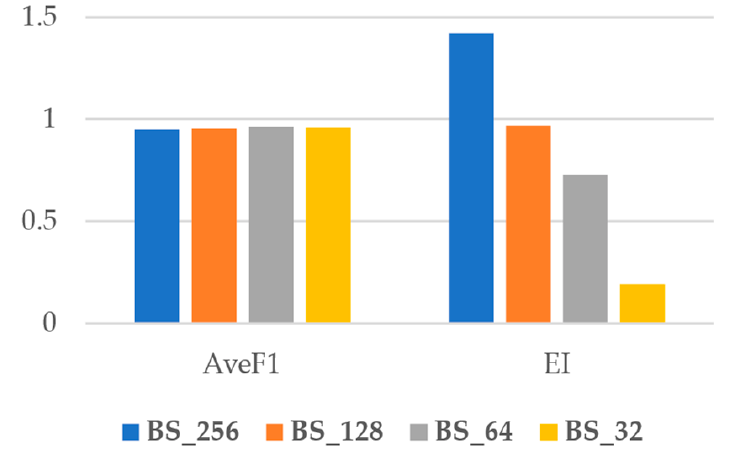
Figure 6. AveF1 and EI index for different batch sizes.